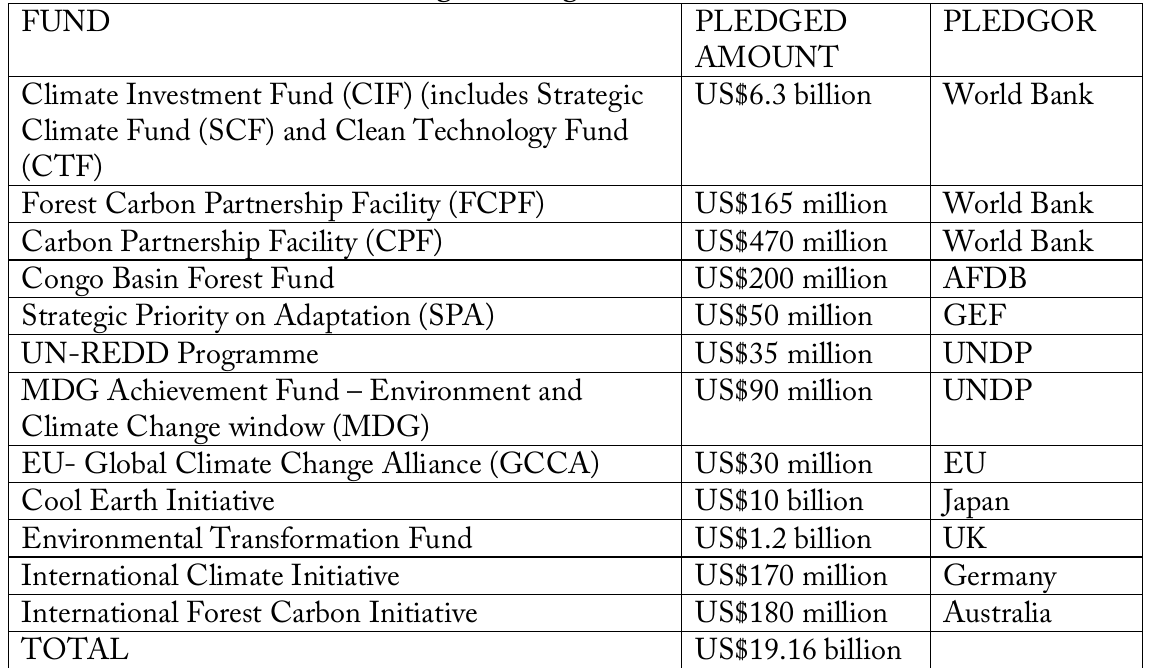
Table 2: Cli mate Change Funding Initiatives outsi de the